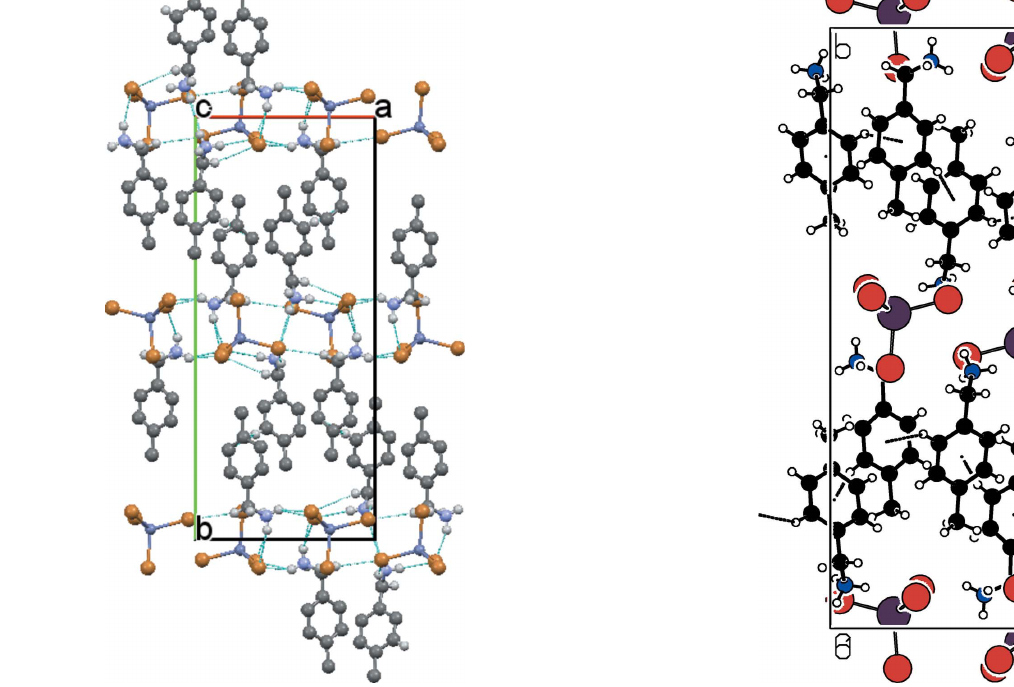
Figure 2 Packing diagram of the title compound viewed along the c axis, showing the alternate stacking, along the b axis, of organic and inorganic layers. Dashed lines indicate the hydrogen-bonding network.